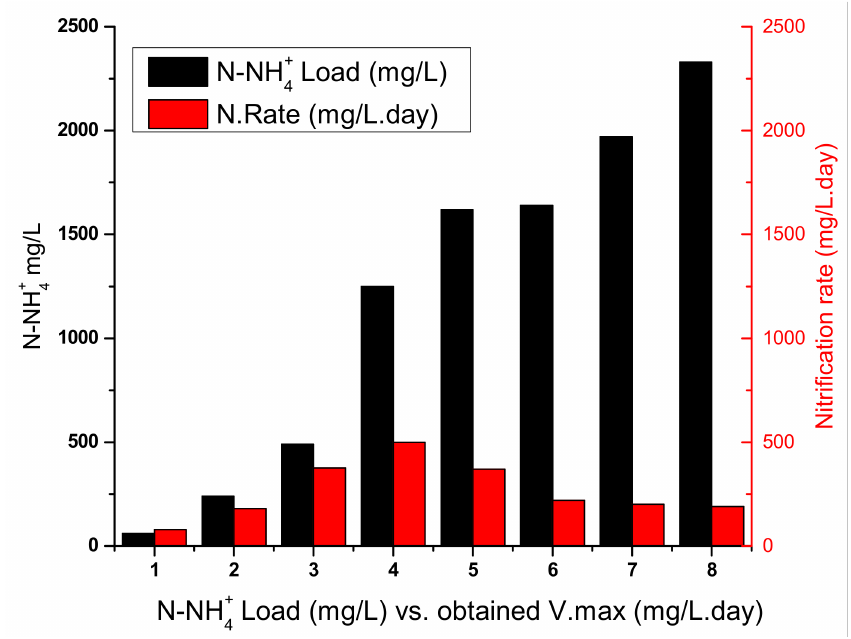
Figure 2. Maximum load of N-NH 4+ and nitrification performance.